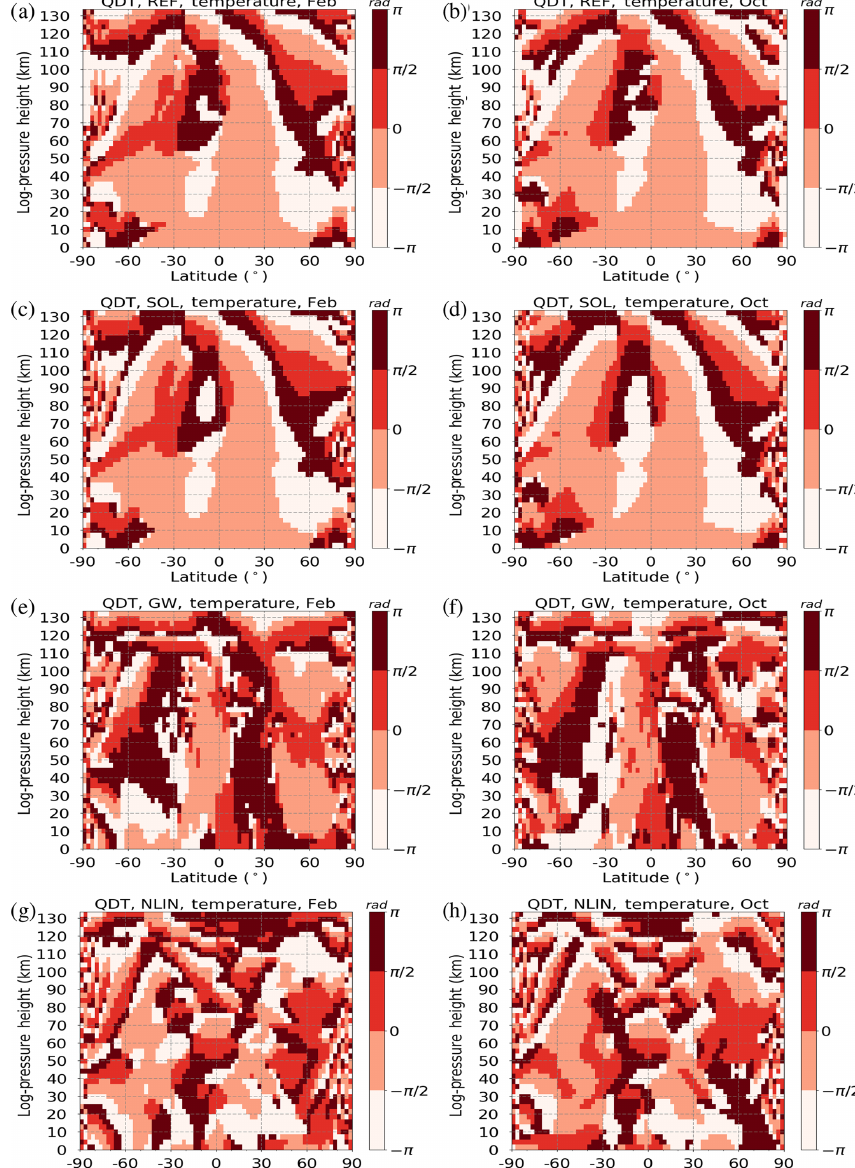
Figure 6. Simulations of zonal mean QDT phases for temperature (colors), showing (a, c, e, g) February and (b, d, f, h) October conditions. Panels (a) and (b) show the REF run with all forcing mechanisms enabled, panels (c) and (d) show the SOL run with only the direct solar forcing mechanism enabled, panels (e) and (f) show the GW run with only the gravity wave forcing mechanism enabled, and panels (g) and (h) show the NLIN run with only the nonlinear forcing mechanism enabled. Standard deviations σ are added as gray contour